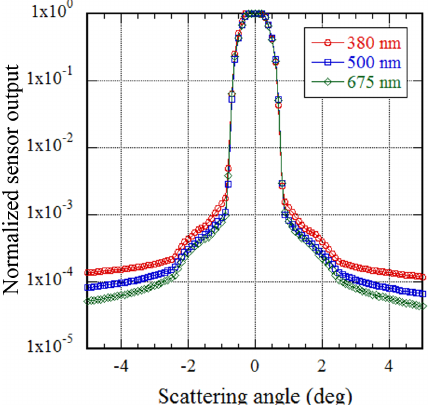
Figure 1. An example of measurement of the sun and the sky around the sun. The measurement was performed keeping the same azimuth angle as the solar azimuth angle. A positive (negative) value means a higher (lower) solar elevation, where the wavelengths are 380nm (red), 500nm (blue), and 675nm (green). The values are normal- ized by the measured value at the zero scattering angle (direct solar